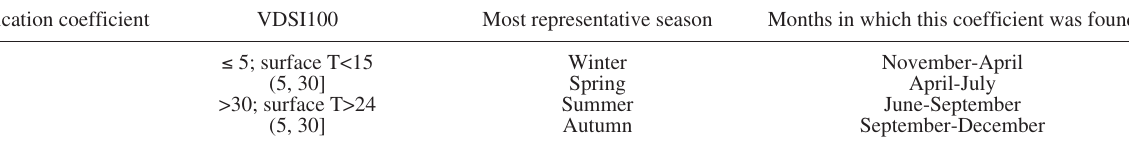
Table 2. – Criteria used to define the stratification coefficient of the profiles according to the vertical stratification index at 100 m depth (VDSI100) calculated.